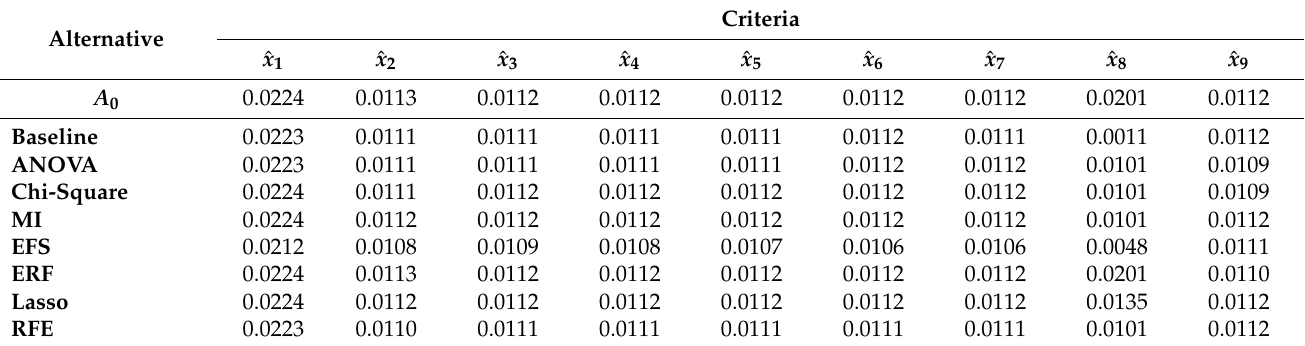
Table 6. Normalization-weighted decision-making matrix ˆ X of each criterion.